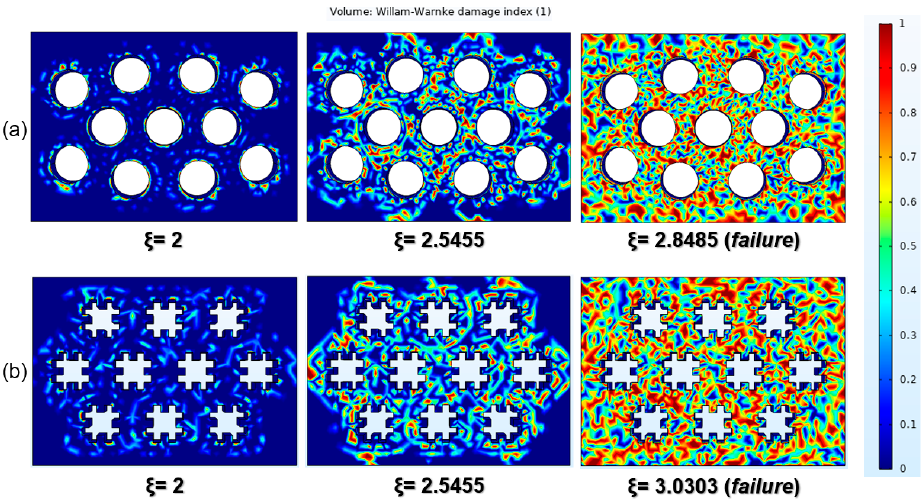
Figure 8. WW damage index distribution in ( a ) CHD model and ( b ) FHD model, considering RuC mix as constituent material.